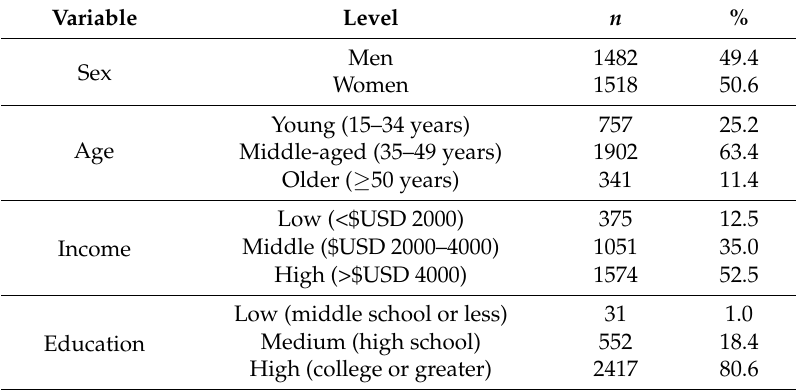
Table 1. Demographic characteristics of the study